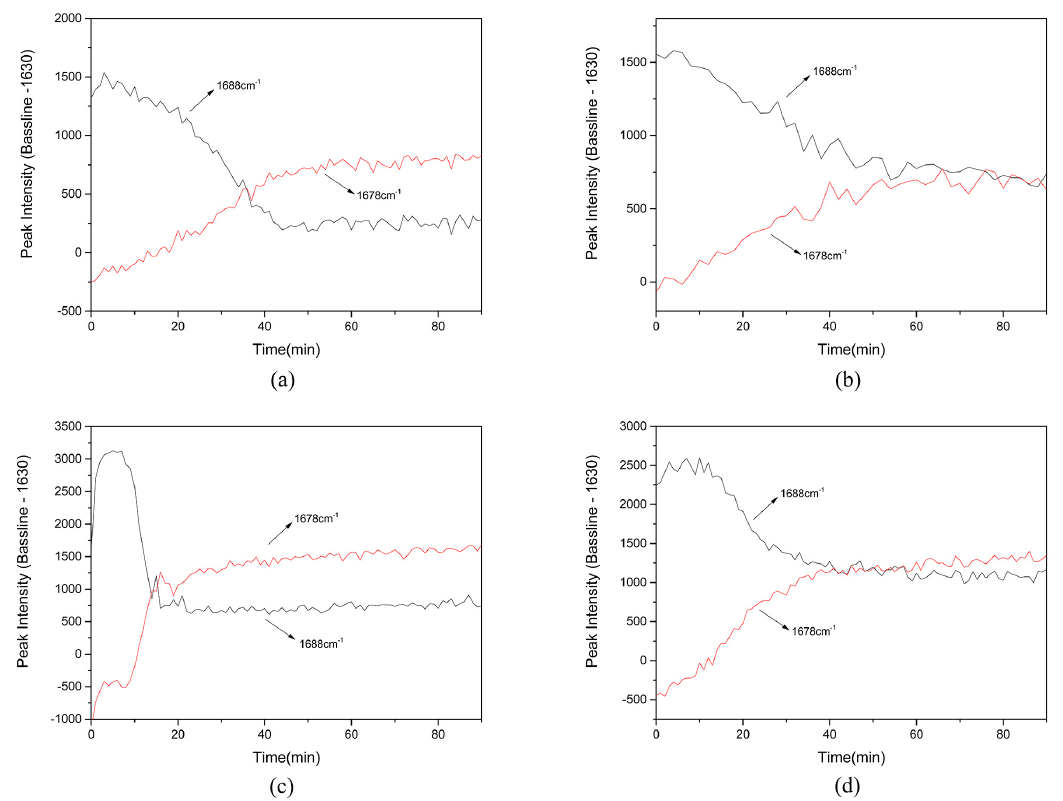
Figure 6. The relative peak intensity during TP-BA cocrystal formation in slurry crystallization: ( a )